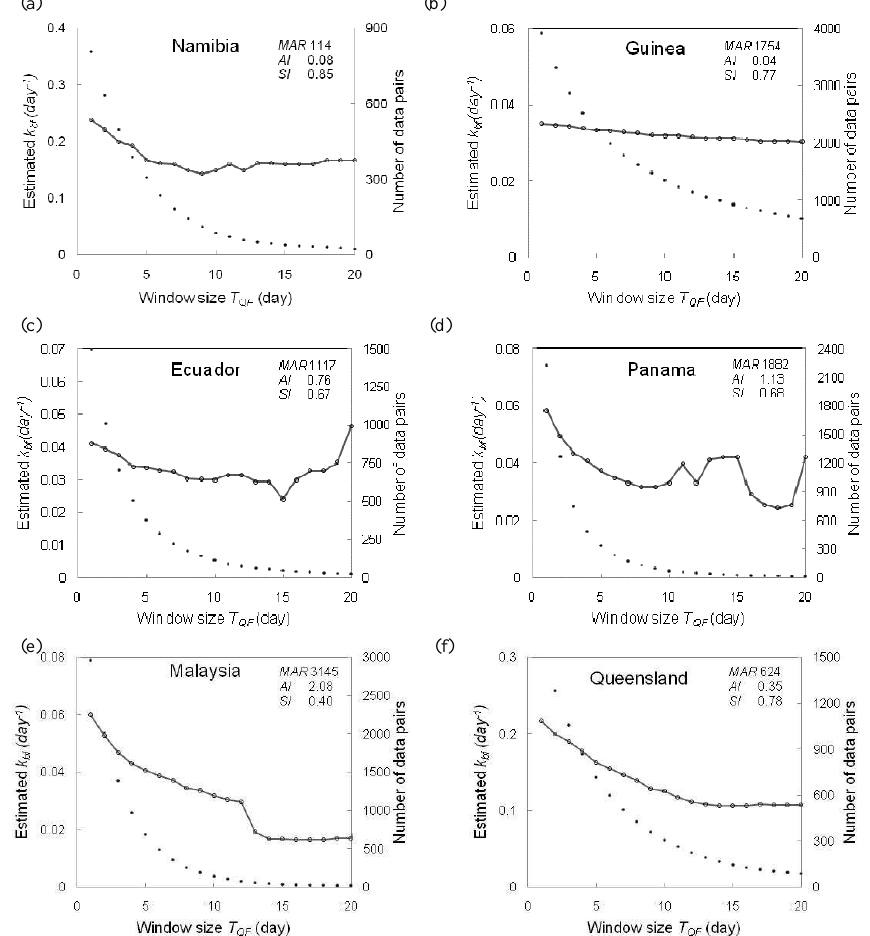
Fig. 4. Variation of estimated recession coefficient k bf (closed lines) and number of Q – Q ∗ data pairs (dots) with an increase in T QF from 0 to 20 days. Values for mean annual rainfall (MAR in mm y − 1 ) , aridity index (AI) and seasonality index (SI) is show for each catchment gauge data.